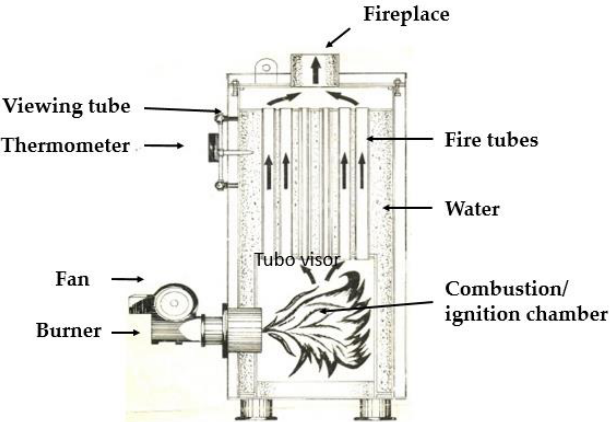
Figure 1. Vertical single-pass hot water boiler. It is built due to lack of space; it is inefficient, it has a single gas passage whose temperature emitted into the environment is very high, around 500 °C, the water is only stored around the fire tubes on the side of the combustion chamber. Eventually, there may be water, but it is usually thermally insulated.